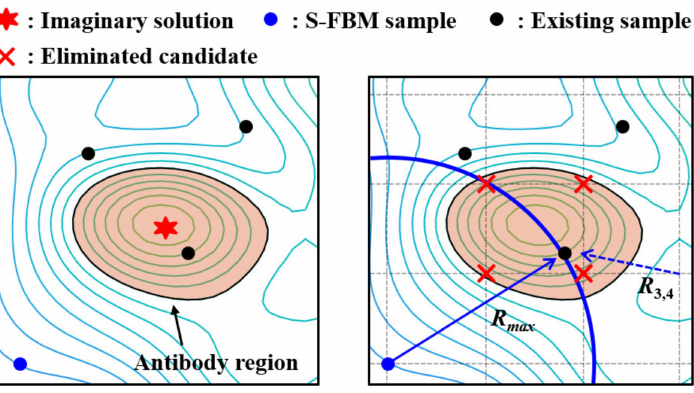
Figure 1. Conceptual schematic of MCS and